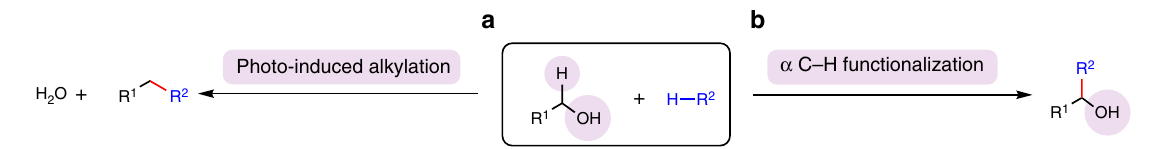
Fig. 2 The transformation of alcohols. a Photo-induced alkylation of heteroarenes by using alcohols as alkylating reagent. b α sp 3 C – H functionalization of